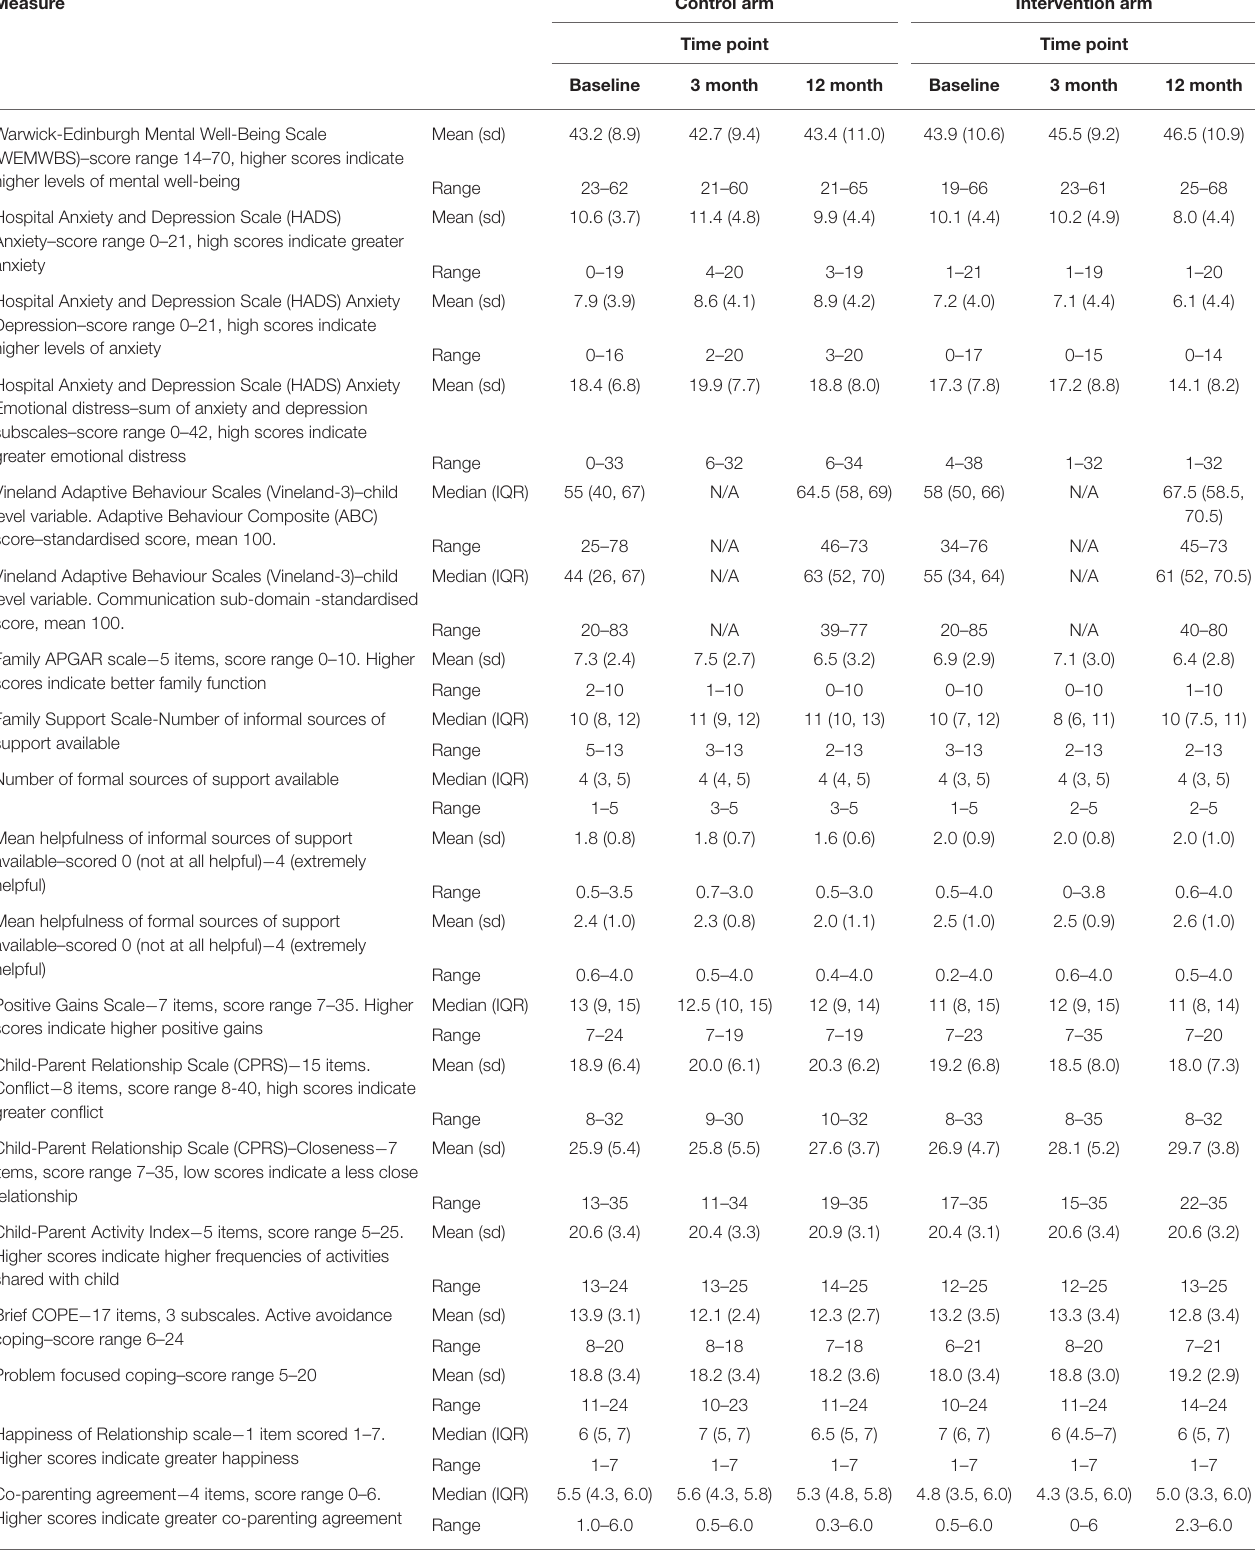
TABLE 6 | Proposed participant-reported outcome measures by trial arm for all participants. Measure Control